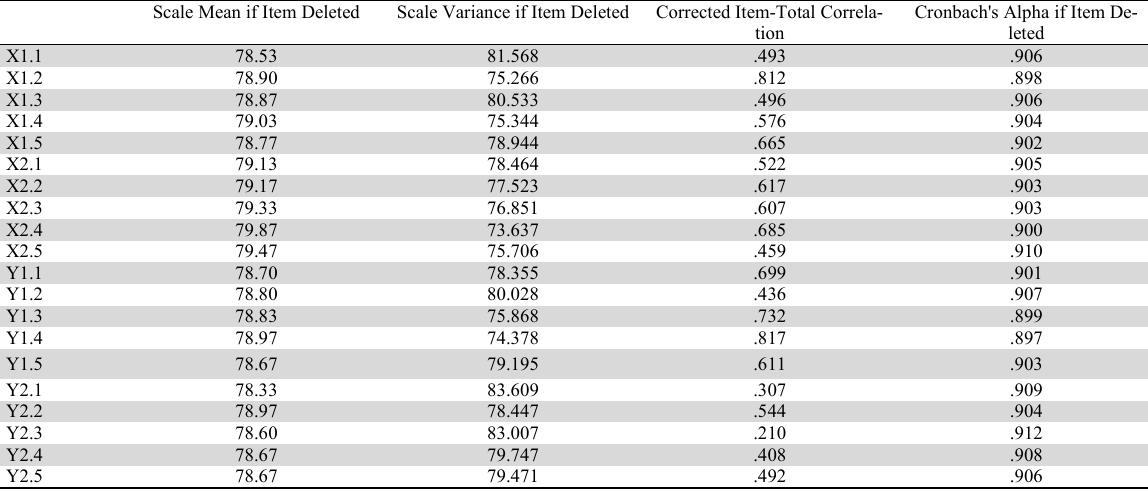
The results of scale mean